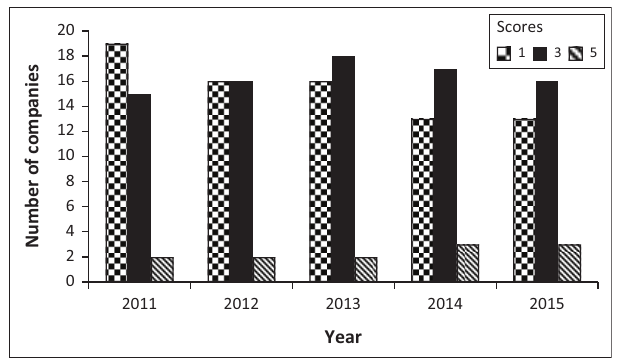
FIGURE 1: Director development depth scores